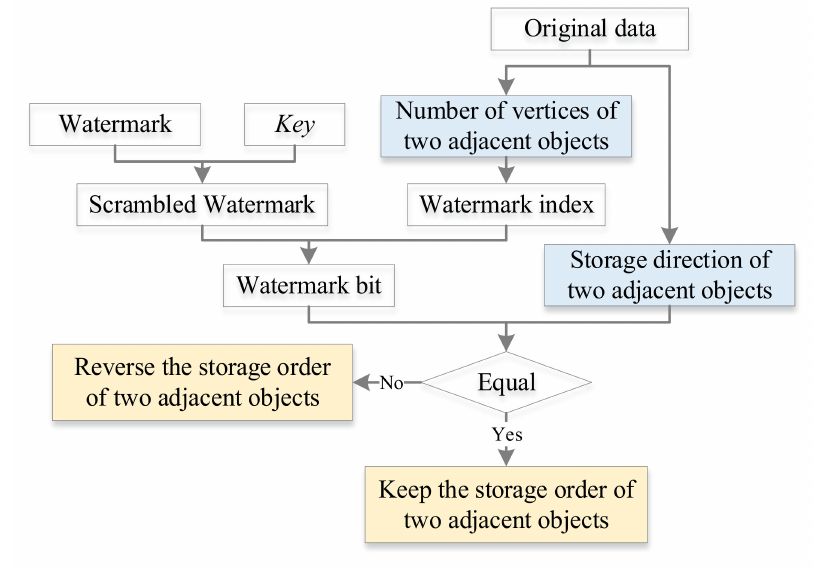
Figure 4. Watermark embedding